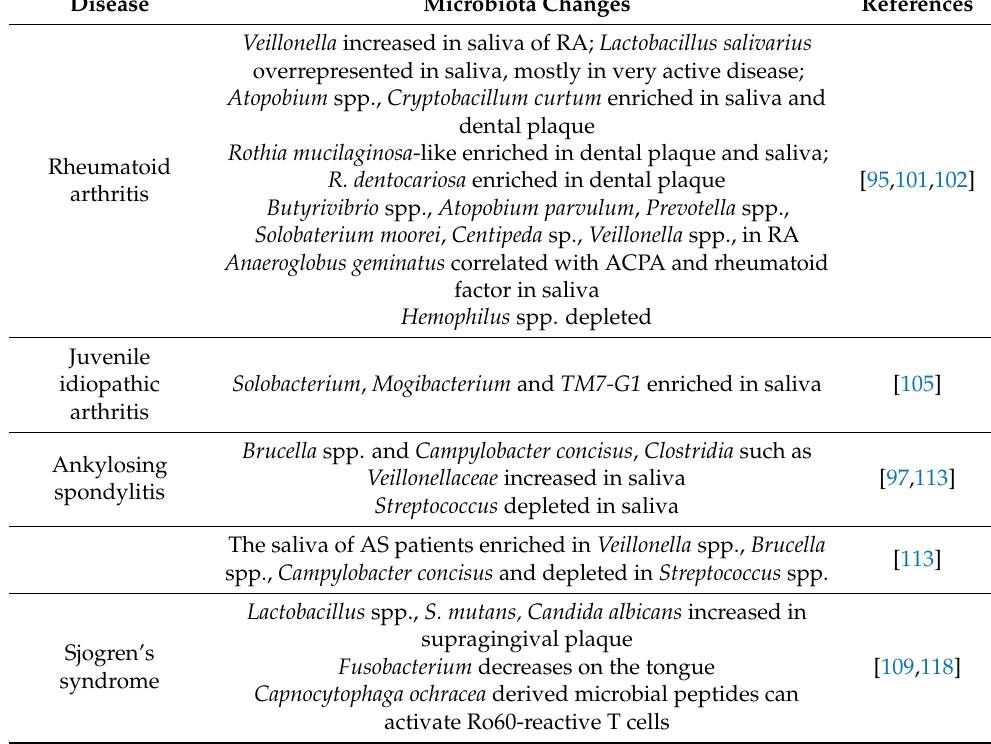
Table 1. Oral microbioma in several autoimmune